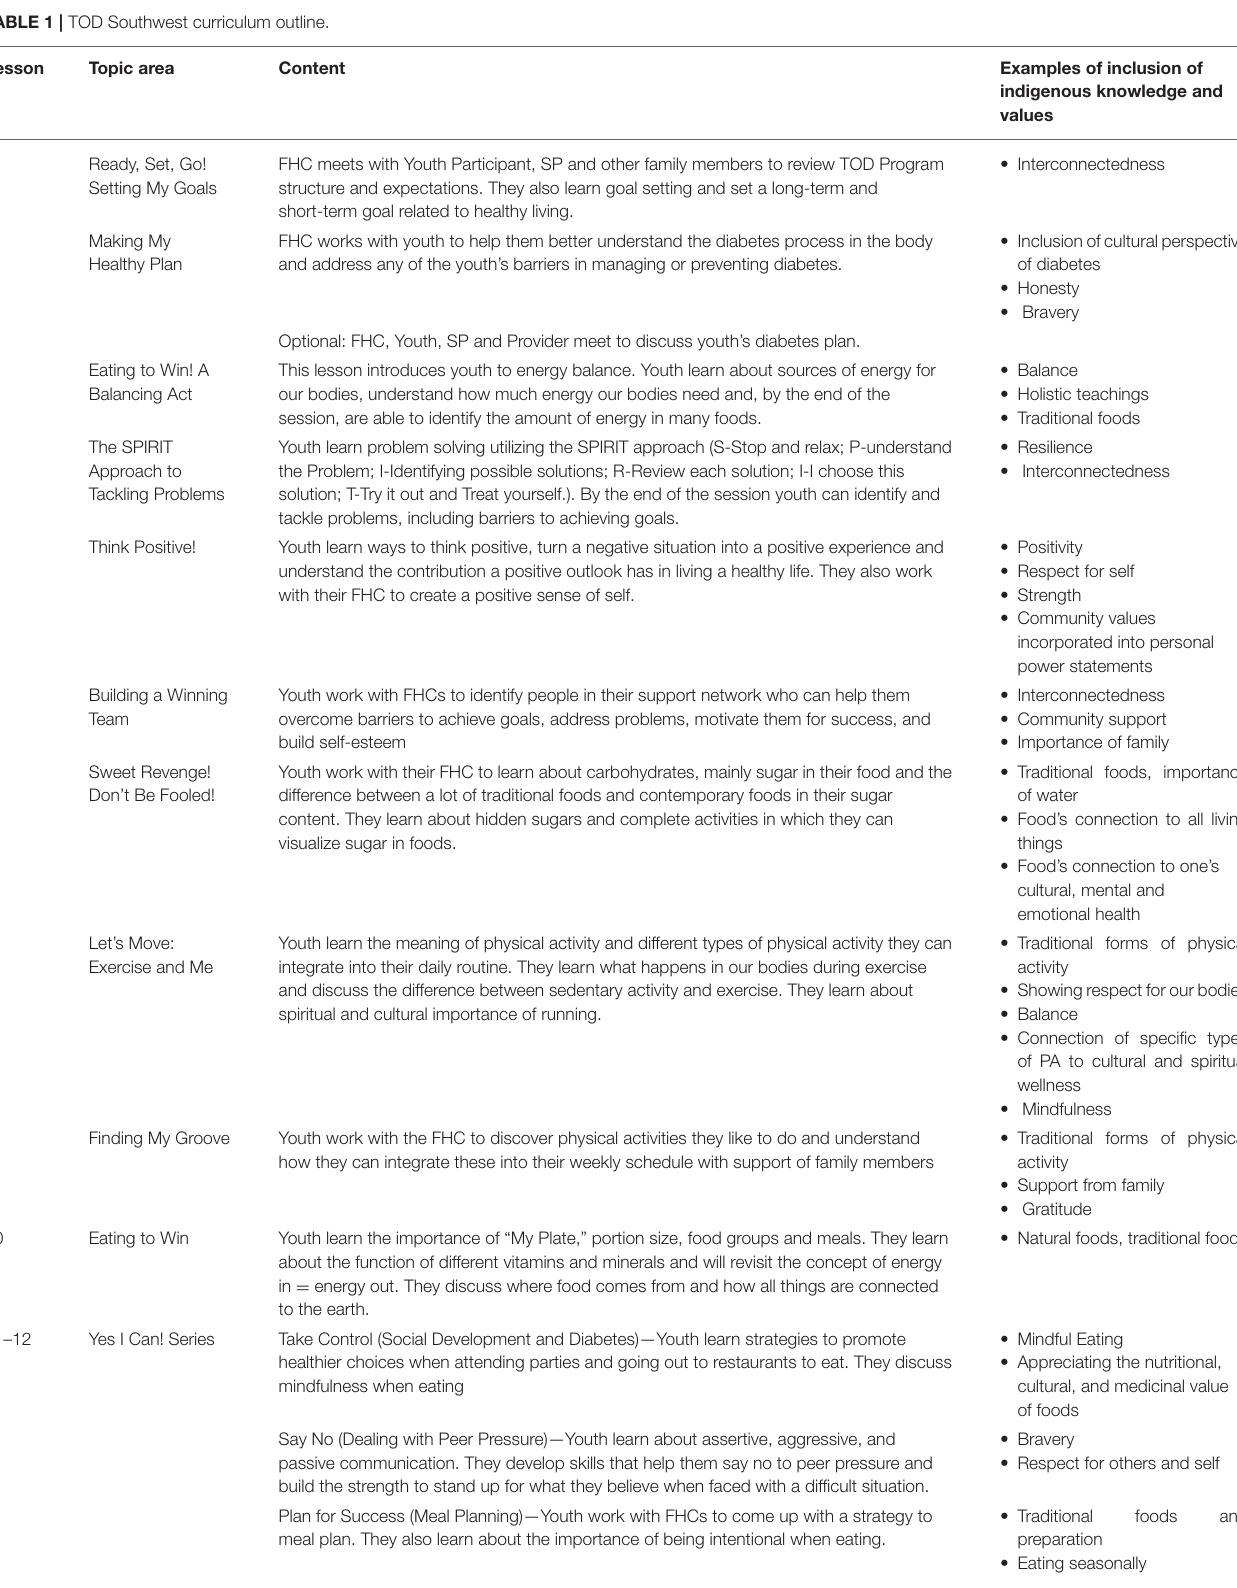
TABLE 1 | TOD Southwest curriculum outline. Lesson Topic